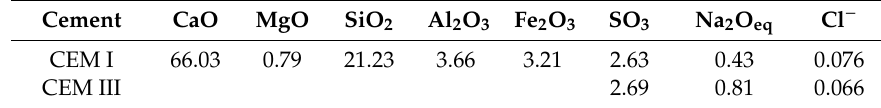
Table 1. Cement composition (%).